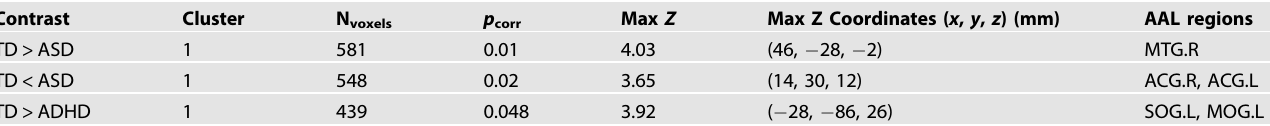
Table 4. Brain regions showing signi fi cant between-group differences in the social > random contrast ( Z > 2.3, p corr <